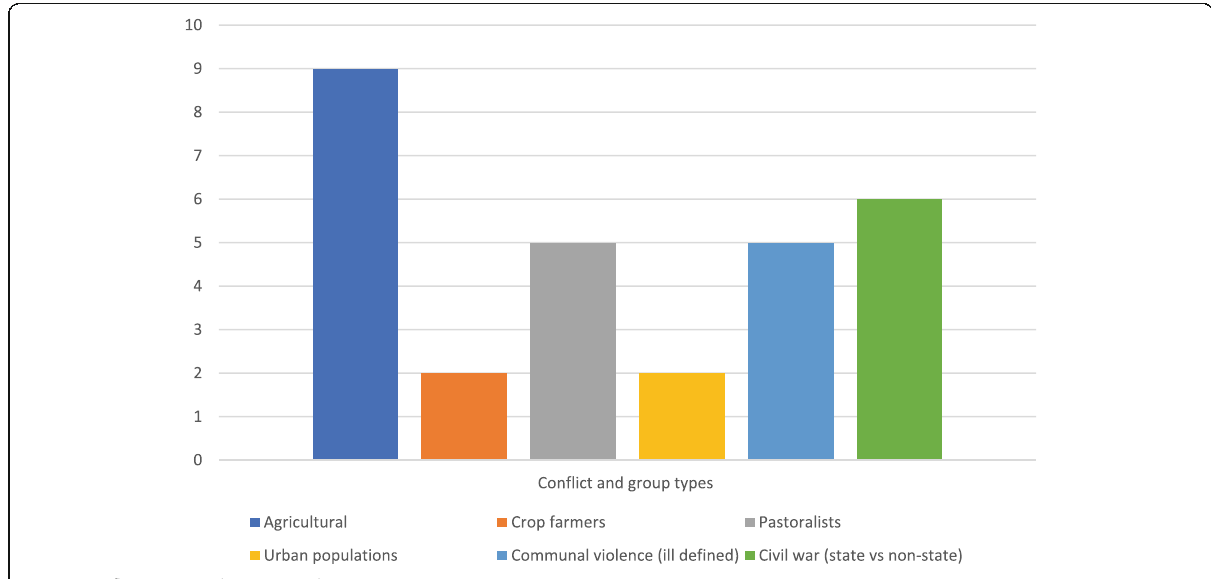
Fig. 1 Conflict types and corresponding